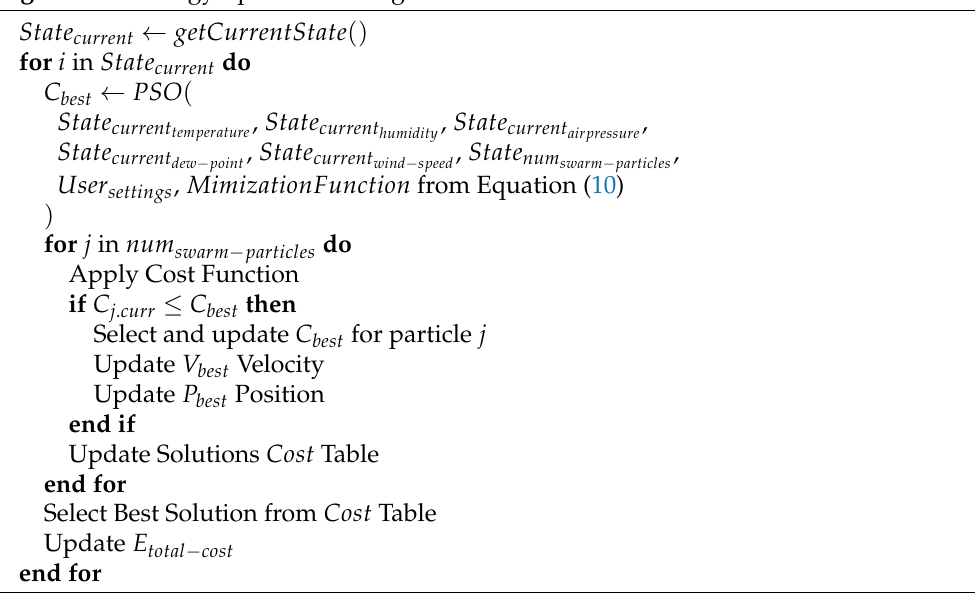
Algorithm 1 Energy-optimization